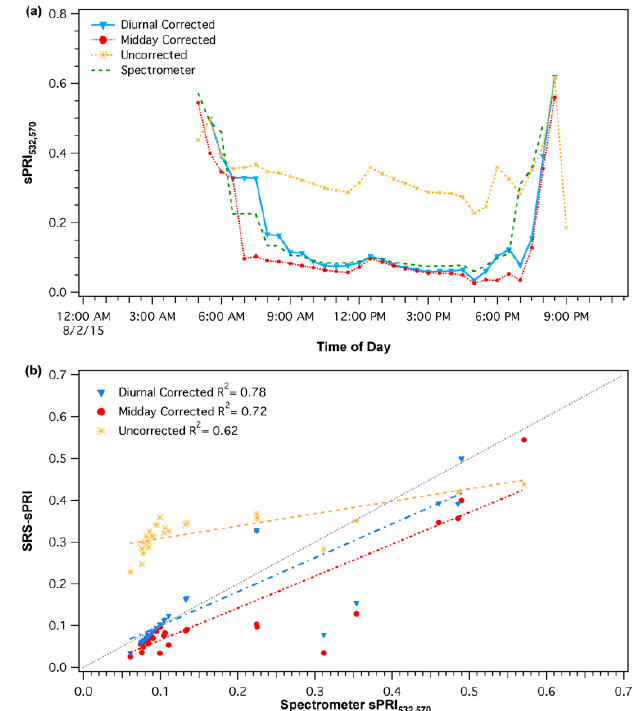
Figure 4. ( a ) Comparison of uncorrected and corrected (diurnal and midday) PRI diurnal patterns. ( b ) Comparison of spectrometer PRI measurements with uncorrected and corrected SRS-PRI measurements. The diurnal cross-calibration procedure shows the strongest and closest correlation to spectrometer readings and 1:1 (gray) line.